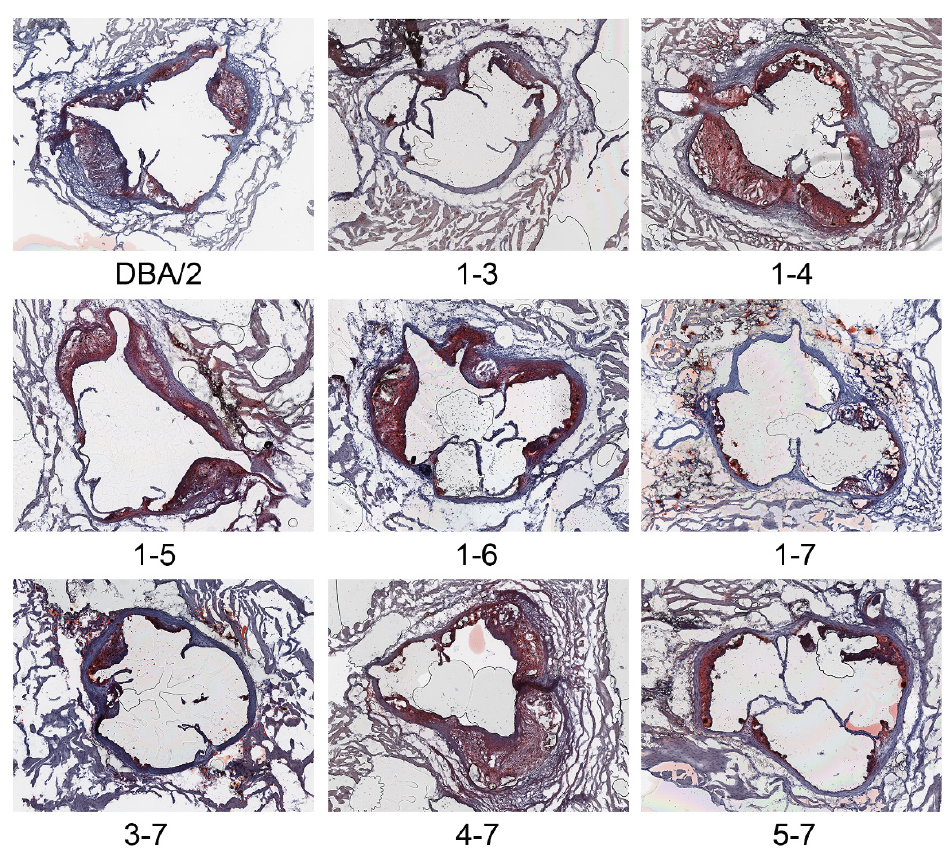
Figure 3. Representative aortic root lesions in female mice from the parental DBA/2 strain and the eight congenic lines stained with Oil red O and hematoxylin. 4× objective lens.